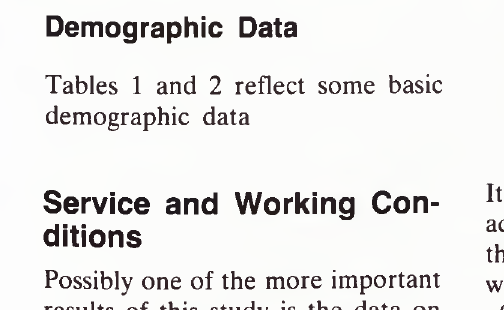
TABLE 1: THE TOTAL GROUP RECRUITED